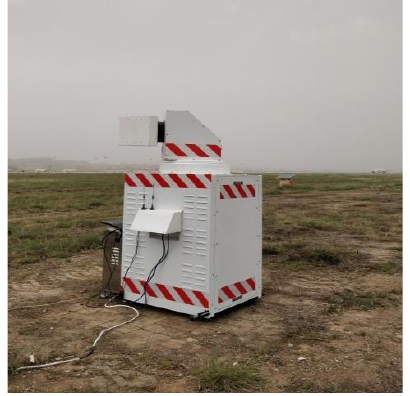
Figure 4. The CDWL in the field experiment.